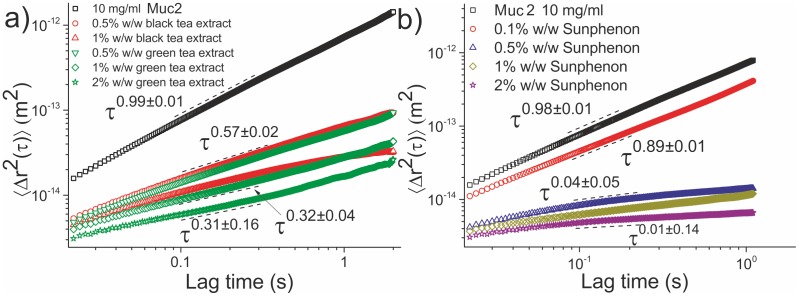
The ensemble averaged MSD curves as a function of lag time for a 10 mg/ml Muc2 solution treated with (a) black and green tea extracts and (b) the EGCG-rich green tea extract Sunphenon 80SK.The addition of green tea extract causes the solution to become viscoelastic, with a monotonic correlation observed between the extract’s concentration and viscoelasticity. Similarly, 0.5% and 1% w/w black tea extract cause the solution to become viscoelastic. At a concentration of 0.1% w/w Sunphenon extract the solution becomes viscoelastic, whereas at a concentration of 0.5% w/w the solution undergoes a sol-gel transition. Increasing the concentration of the extract results in a stronger gel, which is at the limits of what PTM can detect.